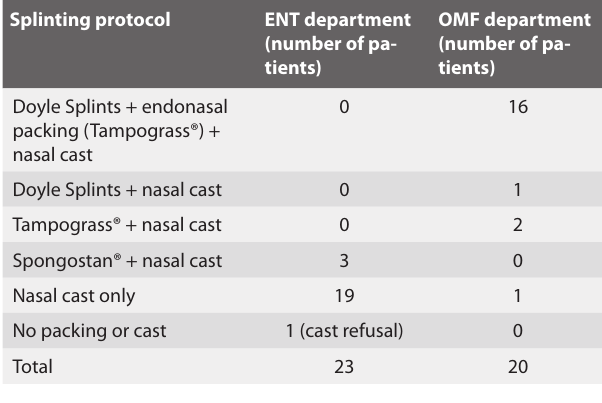
Table 1. Comparison of the different splinting protocols between the two